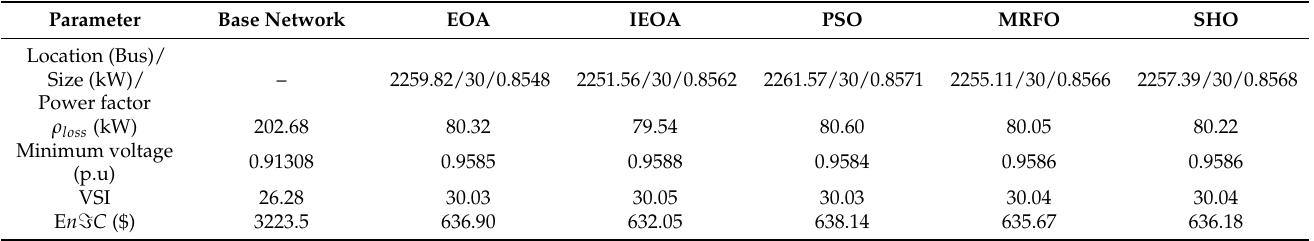
Table 3. The results of multi-criteria wind turbine allocation in the 33-bus network via the DMM.